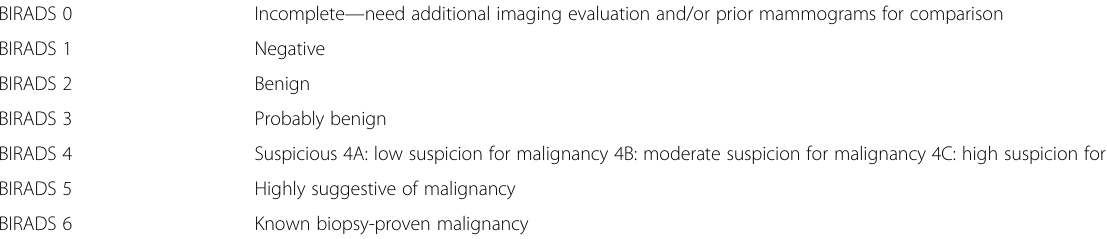
Table 1 BIRADS assessment categories according to BIRADS atlas 2013 category assessment BIRADS 0